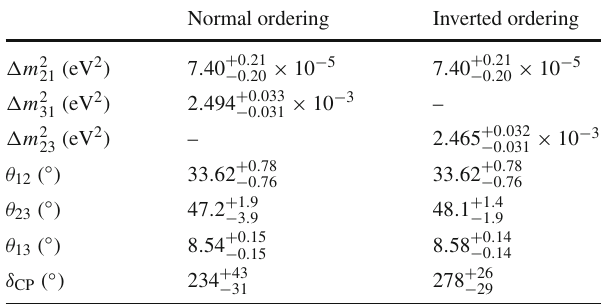
Table 1 Results of a global analysis [62] of mass splittings, mixing angles, and Dirac phase for normal and inverted mass ordering. We best-fit parameters are shown with 1 σ